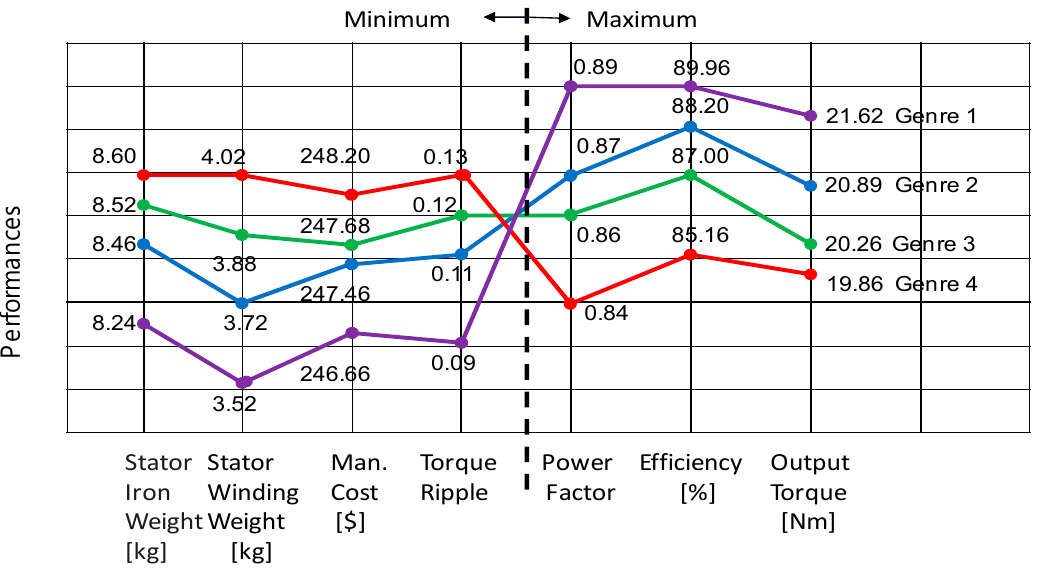
Figure 9. Line chart of performances comparisons for 4 kinds of six-phase synchronous reluctance motors mounted to centrifugal compressor.